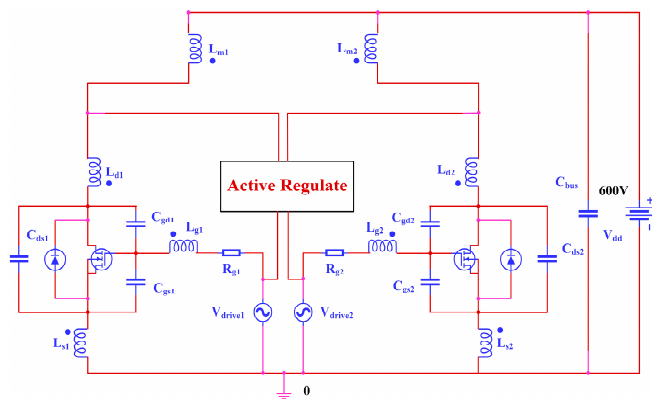
Figure 15. Schematic diagram of the joint simulation.